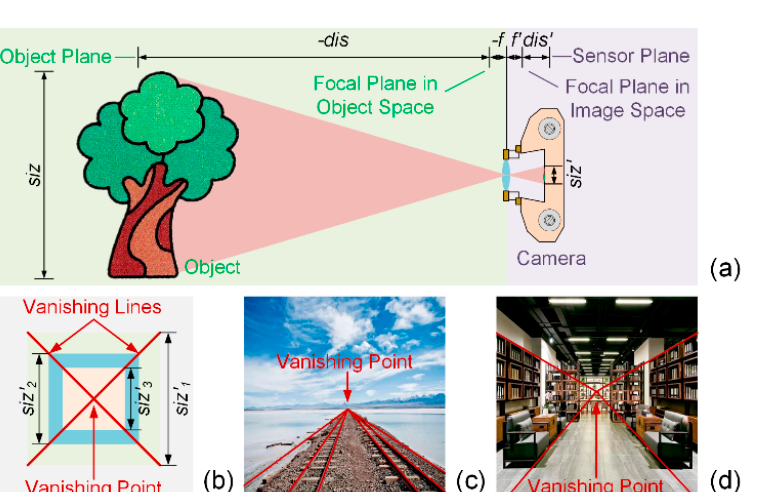
Figure 1. Images captured by lens-based imaging systems. ( a ) Relationship between size of an image and shooting distance in a lens-based imaging system. ( b ) Same size objects distributed along the vanishing lines. ( c ) Vanishing point in distant view image. ( d ) Vanishing point in perspective image. An object located at an infinite distance from the lens appears to be a point in a 2D image. This point is called the vanishing point. In a 2D image, as the distance to the vanishing point changes, objects with a same size appear to be distributed along divergent lines originating at the vanishing point, as shown in Figure 1b. These divergent lines are called vanishing